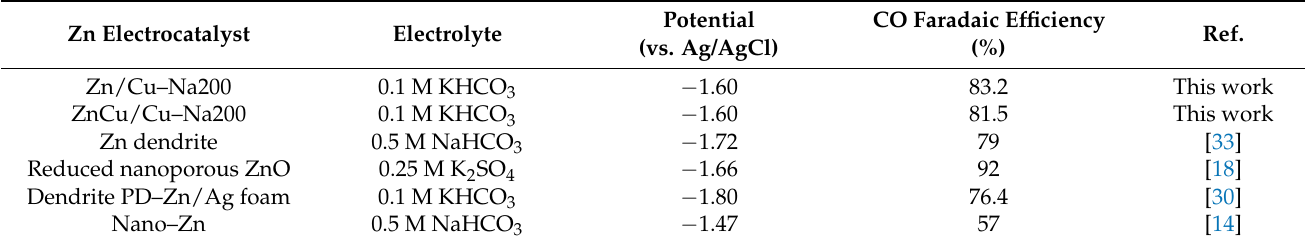
Figure 5. Proposed reaction pathways for CO 2 RR over dendritic and bulky structures of Zn/Cu catalysts. Table 3. Comparison of CO Faradaic efficiency on different Zn electrocatalysts in CO 2 RR. Zn